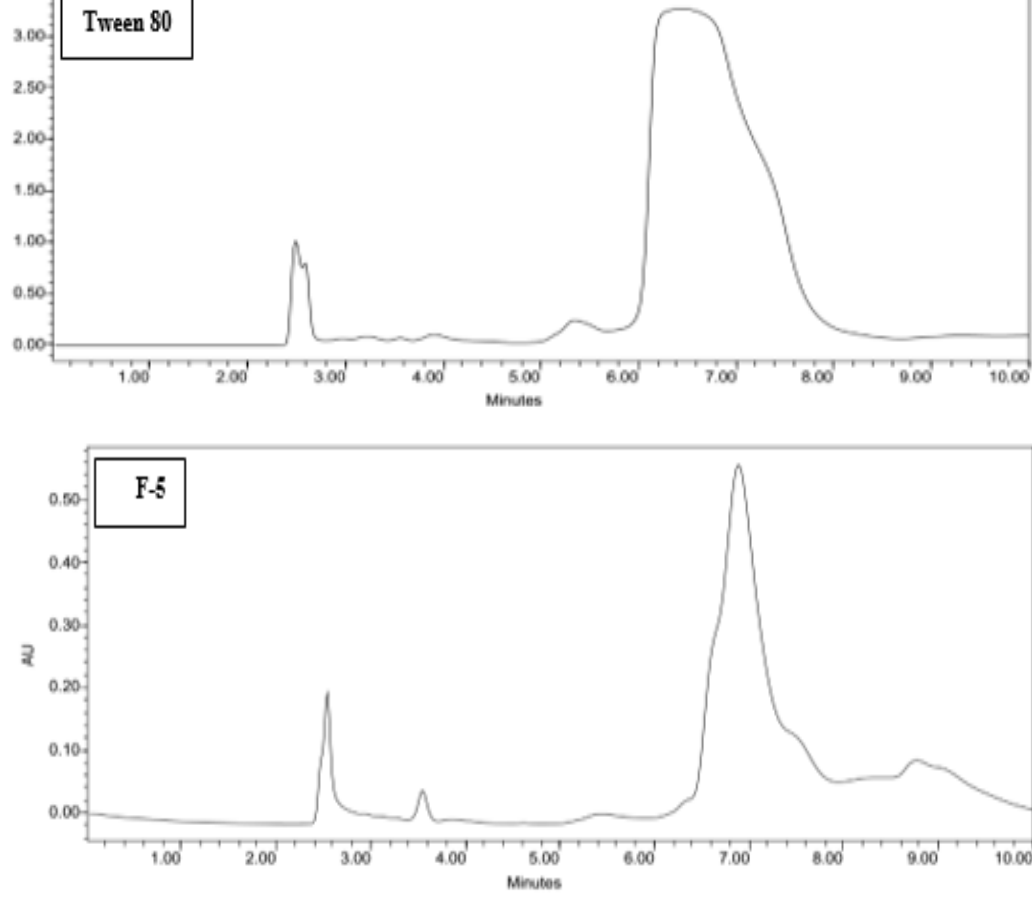
formula F5 performed by AFM were close to spherical in shape and smooth surface (55,56) , as shown in figure